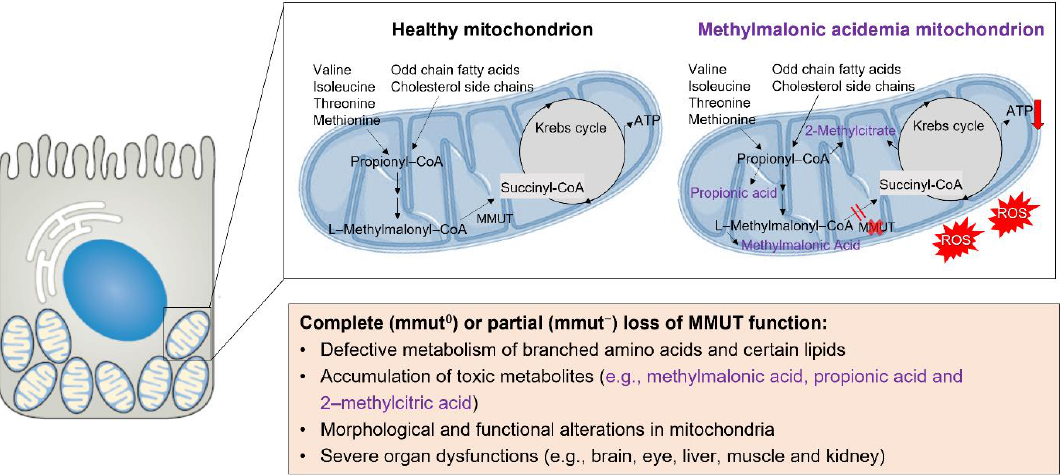
Figure 1. The absence of the enzyme MMUT leads to accumulation of organic acids and mitochondrial abnormalities. Mutations in the MMUT gene encoding the mitochondrial enzyme methylmalonyl-coenzyme A mutase, which mediates the terminal step of branched chain amino acid and odd-chain lipid catabolism, trigger the accumulation of metabolites (e.g., methylmalonic acid, propionic acid, and 2-methylcitric acid) and lack of anaplerosis. This leads to morphologically abnormal mitochondria with disorganized cristae, decreased production of ATP (red arrows) and exaggerated generation of ROS/oxidative stress, ultimately causing severe organ dysfunctions that primarily affect brain, liver, and kidney.